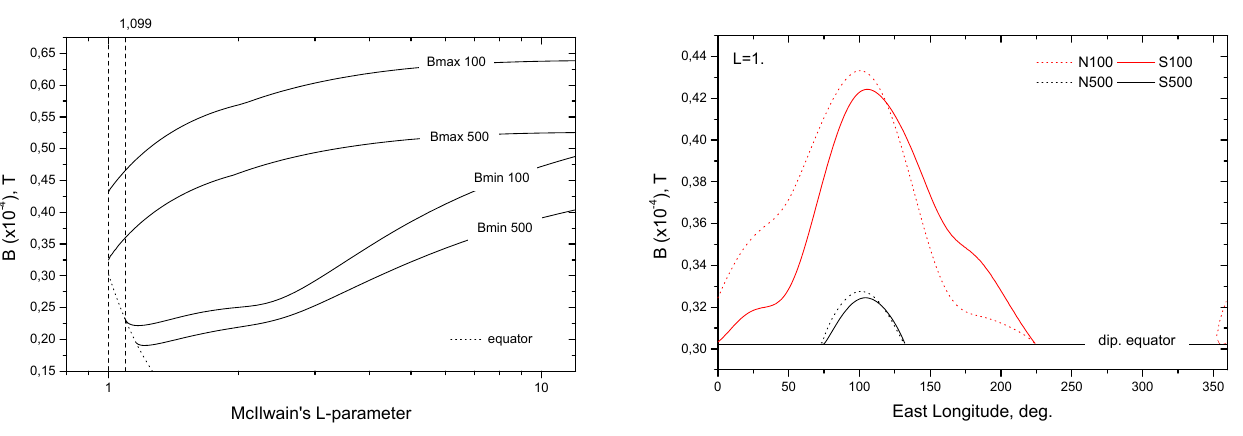
Fig. 1. The levels of 100 and 500km altitudes in L − B space. The lines of the minimum and maximum magnetic field strength at 100 (500)km are marked by Bmin 100 ( 500 ) and Bmax 100 ( 500 ) . The dotted line presents dipole magnetic equator and two dashed vertical lines display L at 1 and 1.099.